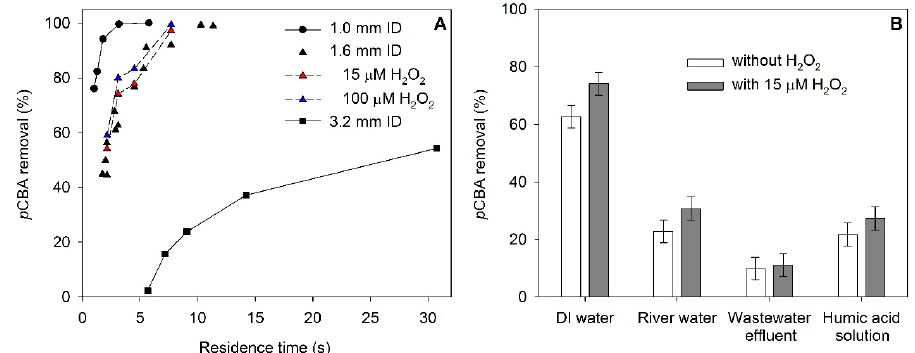
Figure 4. ( A ) Removal of para -chlorobenzoic acid ( p CBA) in pure buffered water and with added H 2 O 2 for different membrane sizes. Three repeats performed with a different membrane each time are shown for the 1.6 mm ID membrane without added H 2 O 2 . ( B ) Removal of p CBA in different water matrices, with and without addition of H 2 O 2 , for the 1.6 mm ID membrane at a residence time of three seconds. River Water I (TOC 7.2 mg/L, pH 7.2), wastewater effluent (TOC 10.2 mg/L, pH 7.9), and humic acid solution (TOC 8.3 mg/L, pH 7.1) were used. TOC: total organic carbon, ID: inner diameter.